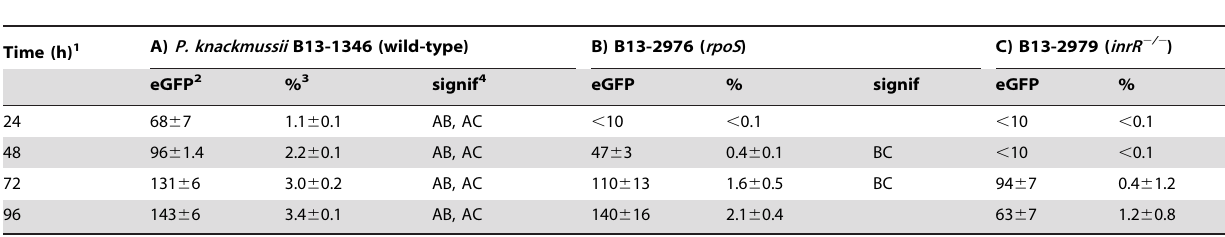
Table 3. Comparison of rpoS with double inrR deletion on eGFP expression from a single copy P int - egfp fusion.